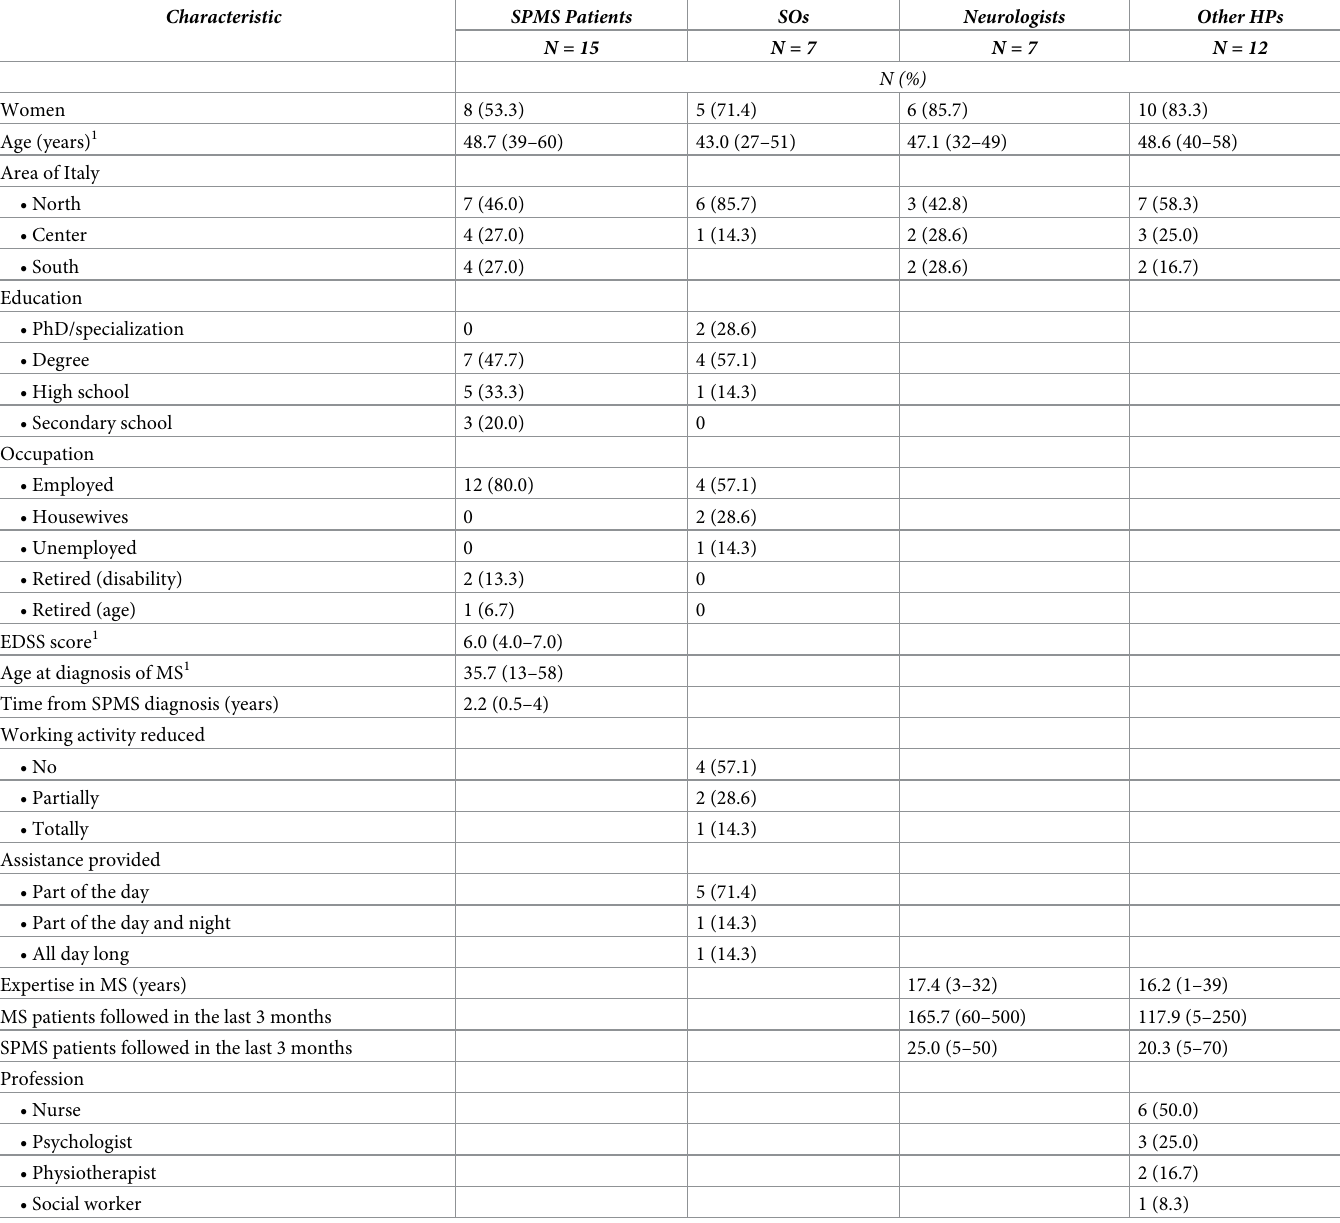
Table 1. Characteristics of participants to personal semi-structured interviews (patients) and focus group meetings (patient significant others, SOs; neurologists; other health professionals, HPs). EDSS, expanded disability status scale; MS, multiple sclerosis; SPMS, secondary progressive multiple sclerosis.